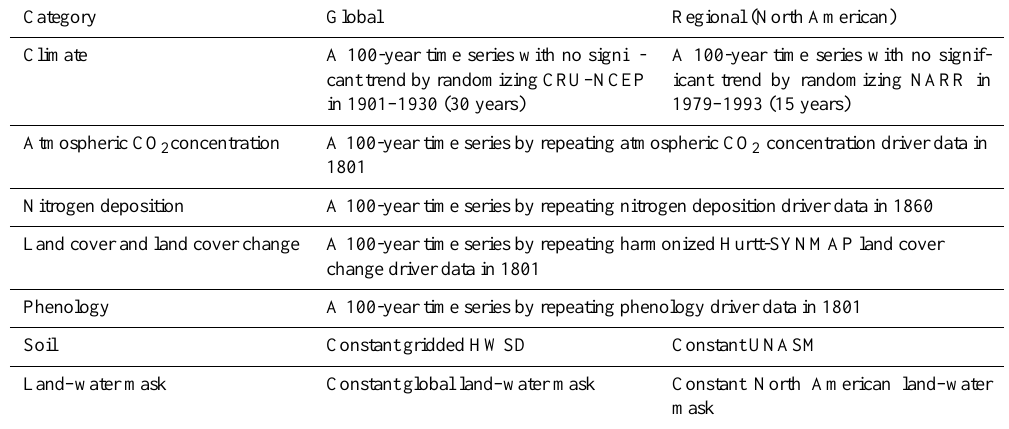
Table 2. The MsTMIP spin-up environmental driver data